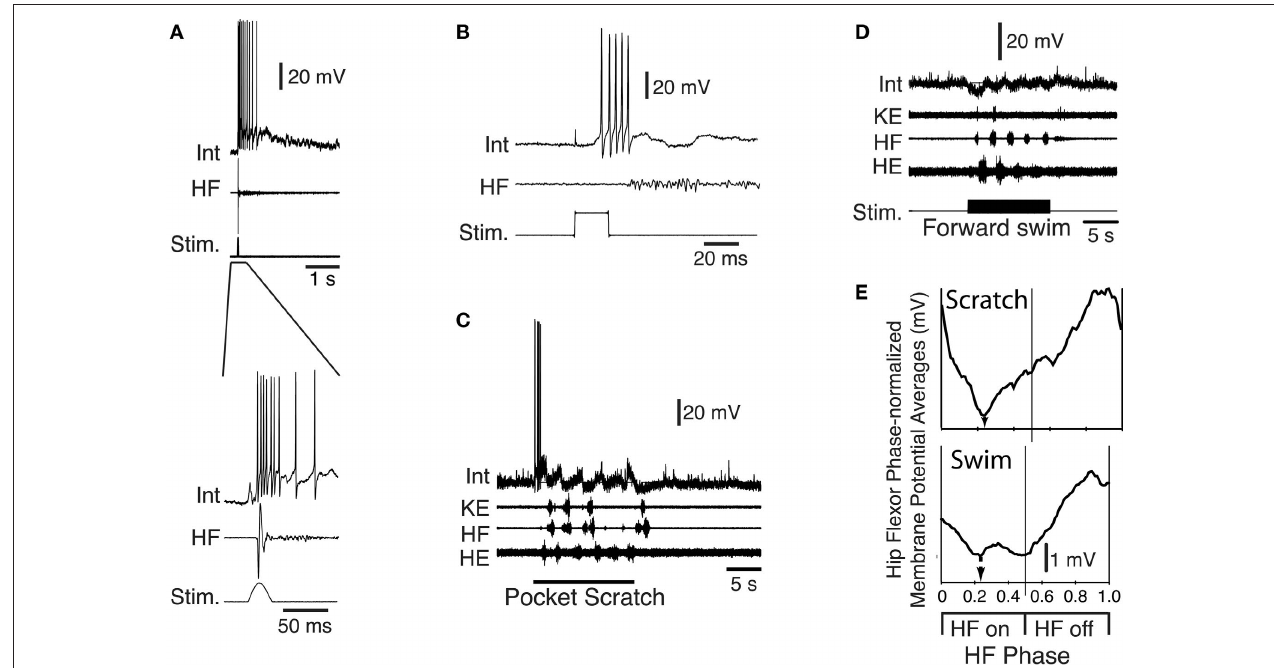
stimulation, but not during the scratch motor pattern; it is rhythmically hyperpolarized during both scratching and swimming. (e) Phase-averaged membrane potential of this neuron during scratching and swimming. HF, hip flexor; Stim., stimulus; KE, knee extensor; HE, hip extensor. Modified from Berkowitz (2007), with permission of the Society for